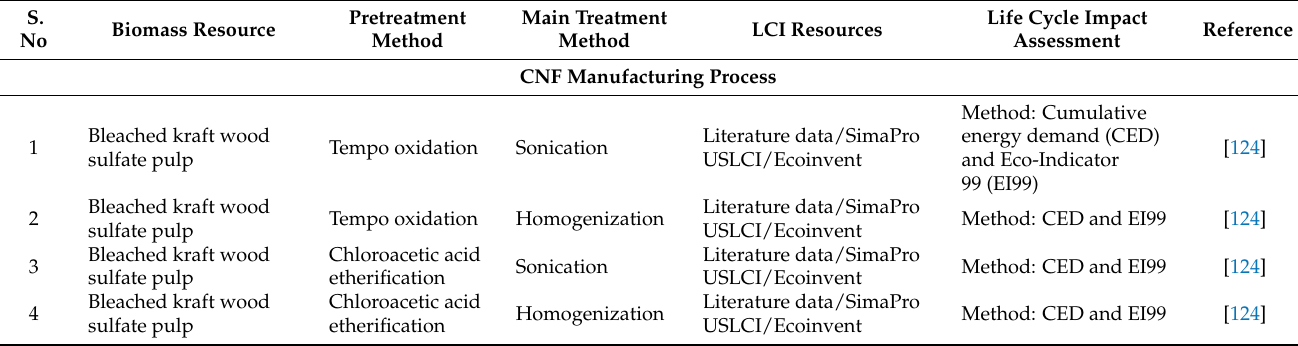
Table 4. Resource, production process, LCI data model, and impact assessment method used in the LCA of CNF/CNC manufacturing